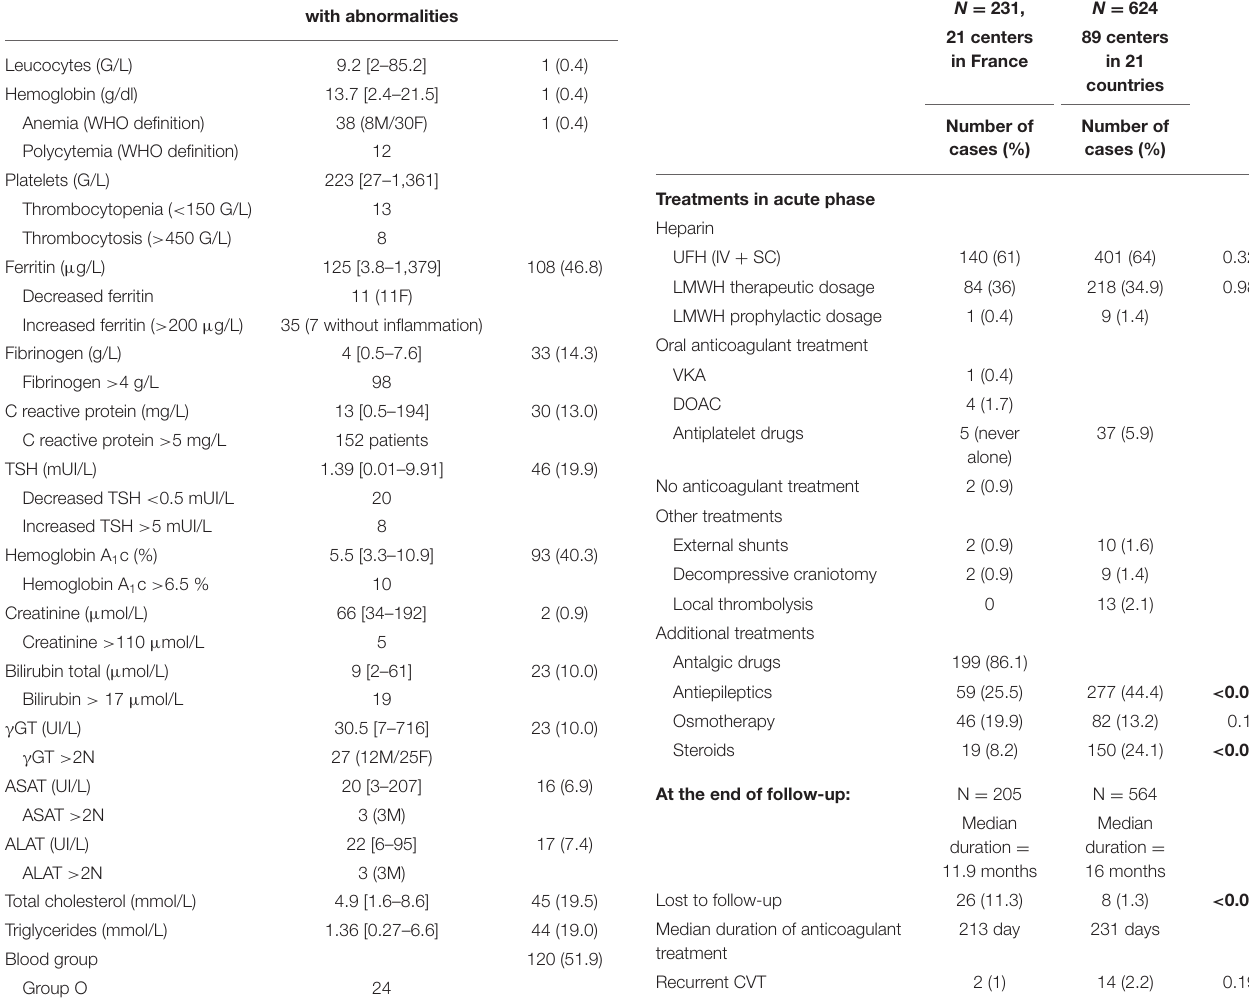
TABLE 4 | Treatments in the acute phase and outcomes at the end of follow-up in TABLE 3 | Routine biological characteristics of the 231 study patients. the FPCCVT and ISCVT cohorts. Median [range], Missing data FPCCVT,